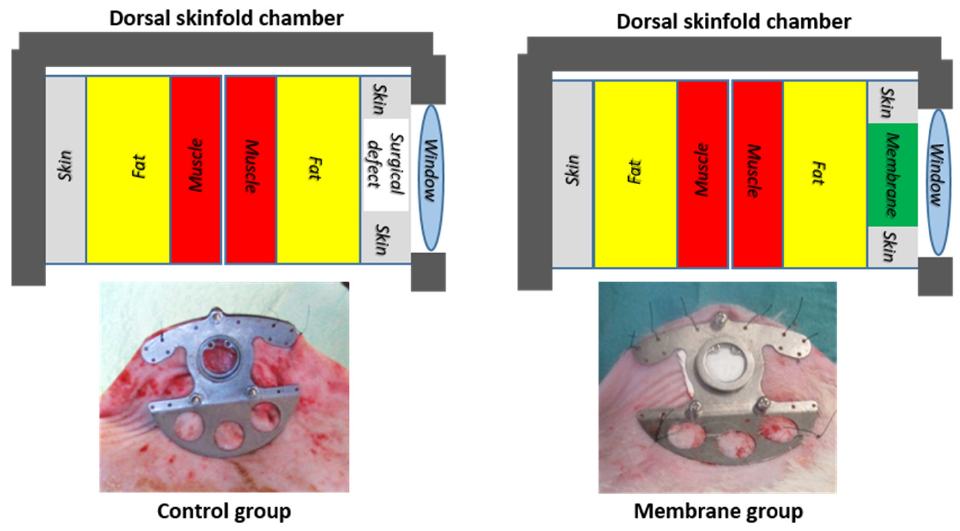
Figure 2. Schematic representation and images of the dorsal skinfold chamber in the rat’s dorsum in control and membrane groups.